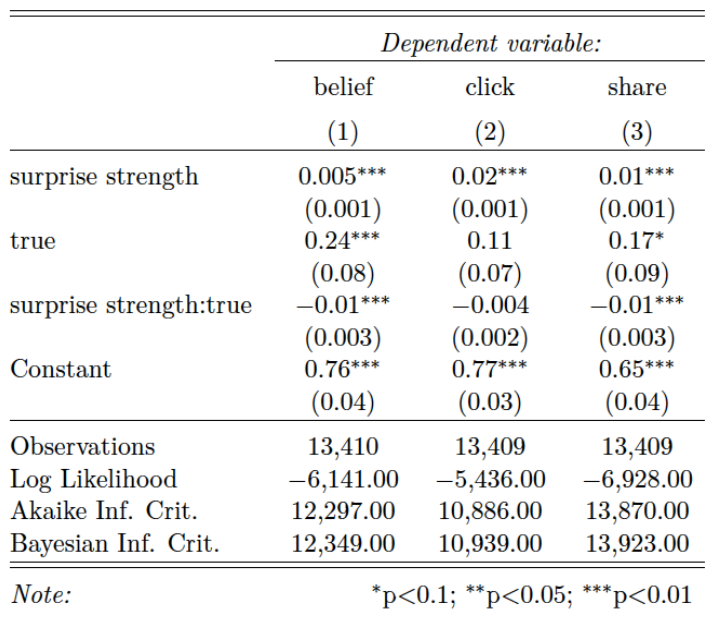
Table C2. Strength of emotion and outcomes: